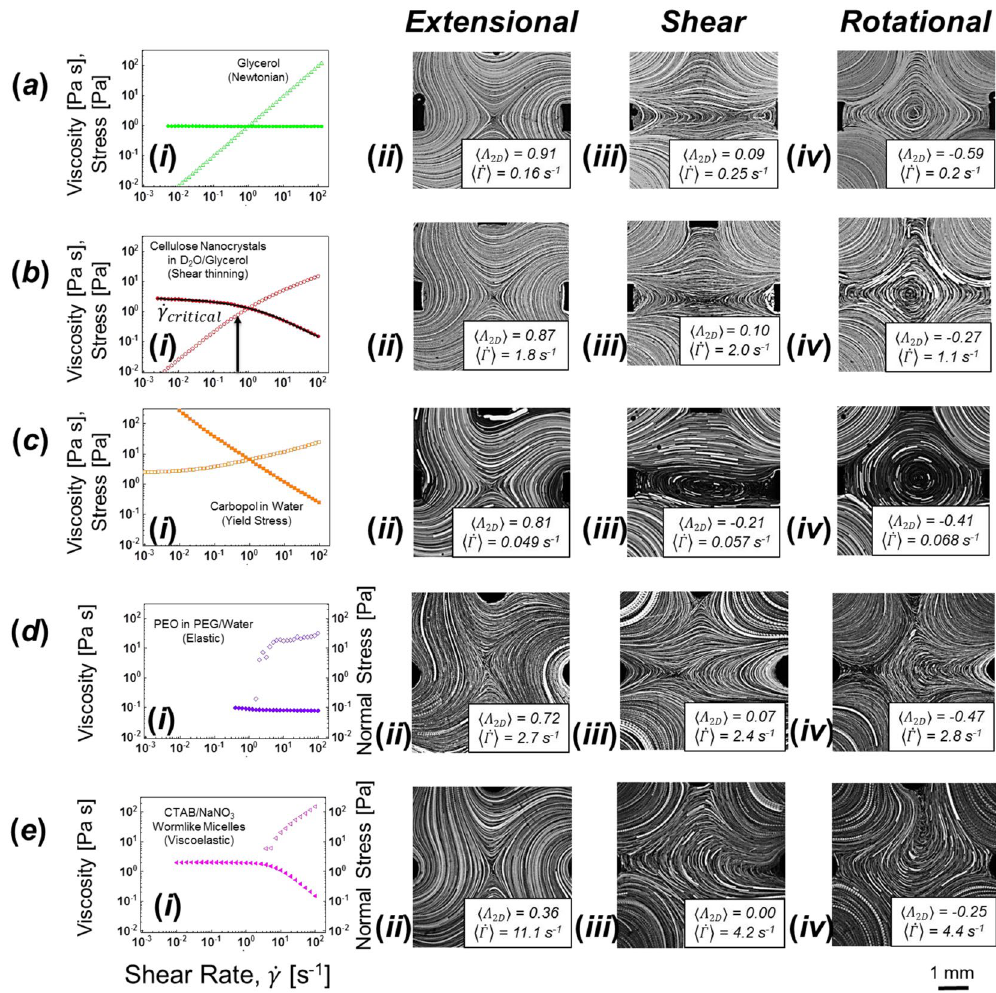
Figure 6. Steady shear rheology (left, i ) and streaklines for conditions that generate extensional, shear and rotational flows for a Newtonian fluid (from left to right, ii to iv ) for ( a ) a Newtonian fluid and several fluids exhibiting non-Newtonian shear rheological responses: ( b ) shear thinning, ( c ) yield stress, ( d ) elastic, ( e ) viscoelastic. Operating conditions are set to those that generate extensional ( Q 1 / Q 2 = 1), shear ( Q 1 / Q 2 = − 0.7), and rotational ( Q 1 / Q 2 = − 1) flows of the Newtonian fluid. Steady shear rheology plots include viscosity (filled shapes) and shear stress (open shapes) as a function of the shear rate for all fluids except the viscoelastic fluid for which the normal stress is included instead of shear stress. The solid line in (bi) is a best fit of the viscosity data to the Carreau